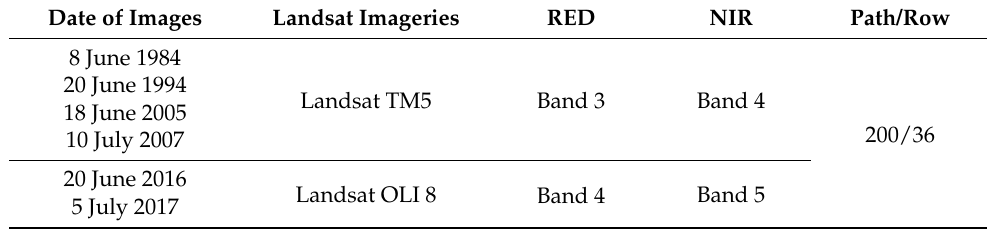
Table 1. TM5 and Landsat 8 thermal